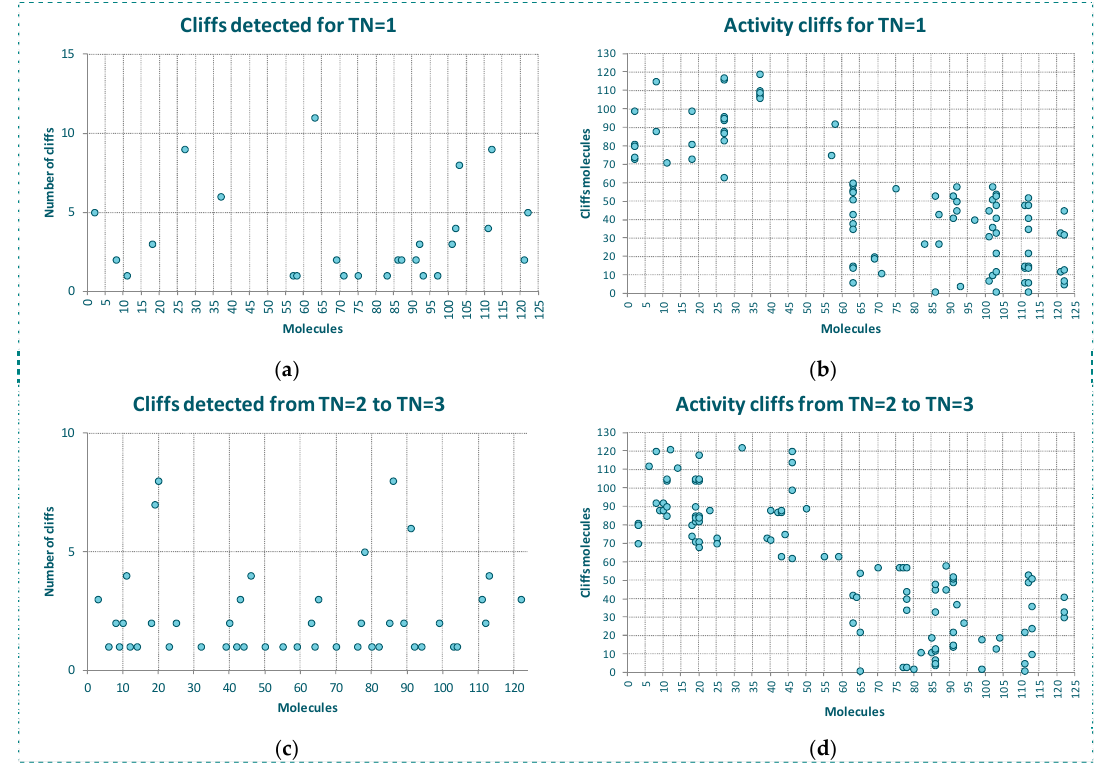
Figure 8. Study of the outlier behavior for MRP4 dataset: ( a ) number nearest neighbors of a different class for the molecules of the dataset for TN = 1, ( b ) pairs of activity cliffs for TN = 1, ( c ) number nearest neighbors of a different class for the molecules of the dataset for TN = 2 to TN = 3 , ( d ) pairs of activity cliffs for TN = 2 to TN = 3.